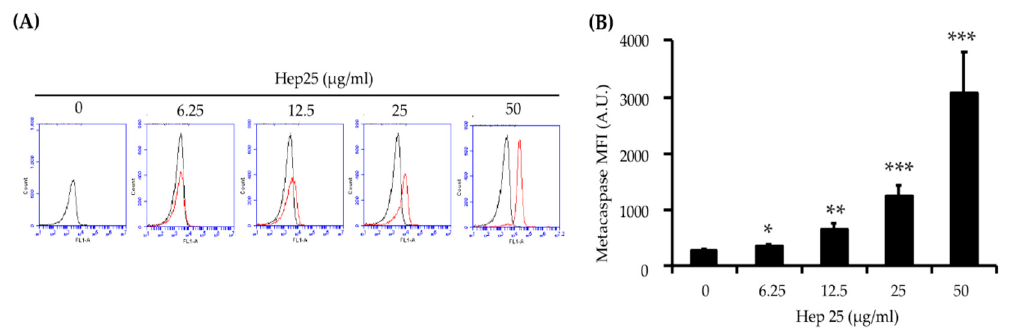
Figure 7. The activation of metacaspases by hep 25. Metacaspase activity induced by hep 25 was detected using the FITC-VAD-FMK in situ marker. In the flow cytometry data ( A ), the black line represents the cells without hep 25 treatment, which served as the negative control. The red line represents cells treated with various concentrations of hep 25. After treatment with hep 25, the cells were incubated with FITC-VAD-FMK for 20 min at RT in the dark and analyzed with a flow cytometer. The quantification data for ( B ). The results are expressed as the mean ± standard deviation of three independent experiments; * p < 0.05; ** p < 0.01; and *** p < 0.001.